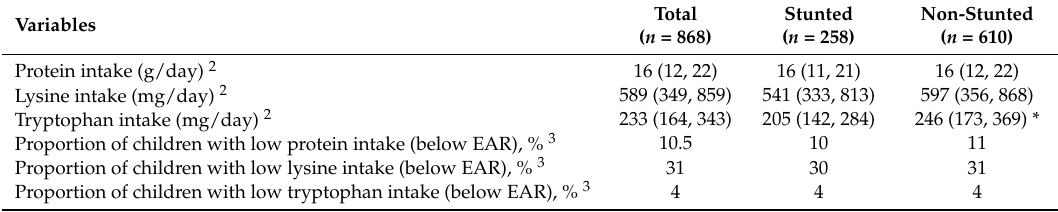
Table 3. Dietary protein and essential amino acids intake of children 1